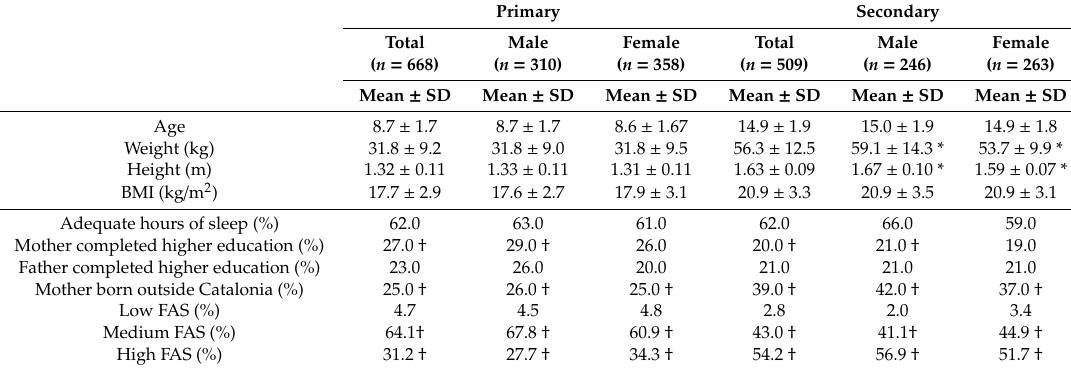
Table 1. Description of the main characteristics of the sample of primary and secondary school groups according to sex 1